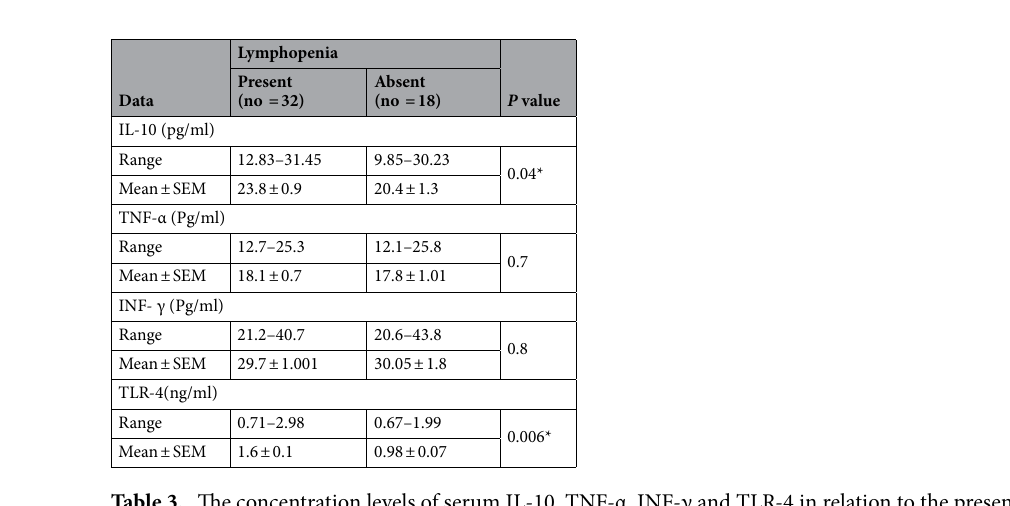
Table 3. The concentration levels of serum IL-10, TNF-α, INF-γ and TLR-4 in relation to the presence of lymphopenia. *Significant level at P value <